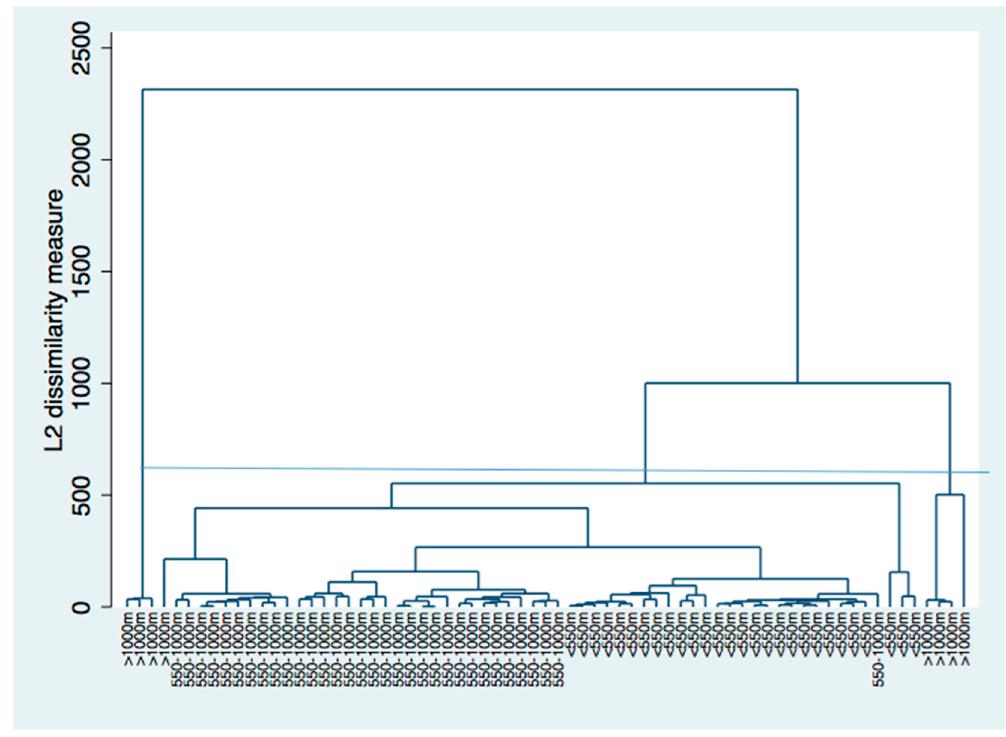
Figure 2. Dendrogram for sex exposure and latency of the cluster analysis. Two main clusters are evident, corresponding to the people resident at a distance of >1000 m and another corresponding to people living at a distance of <1000 m (<500 m and 500–1000 m).